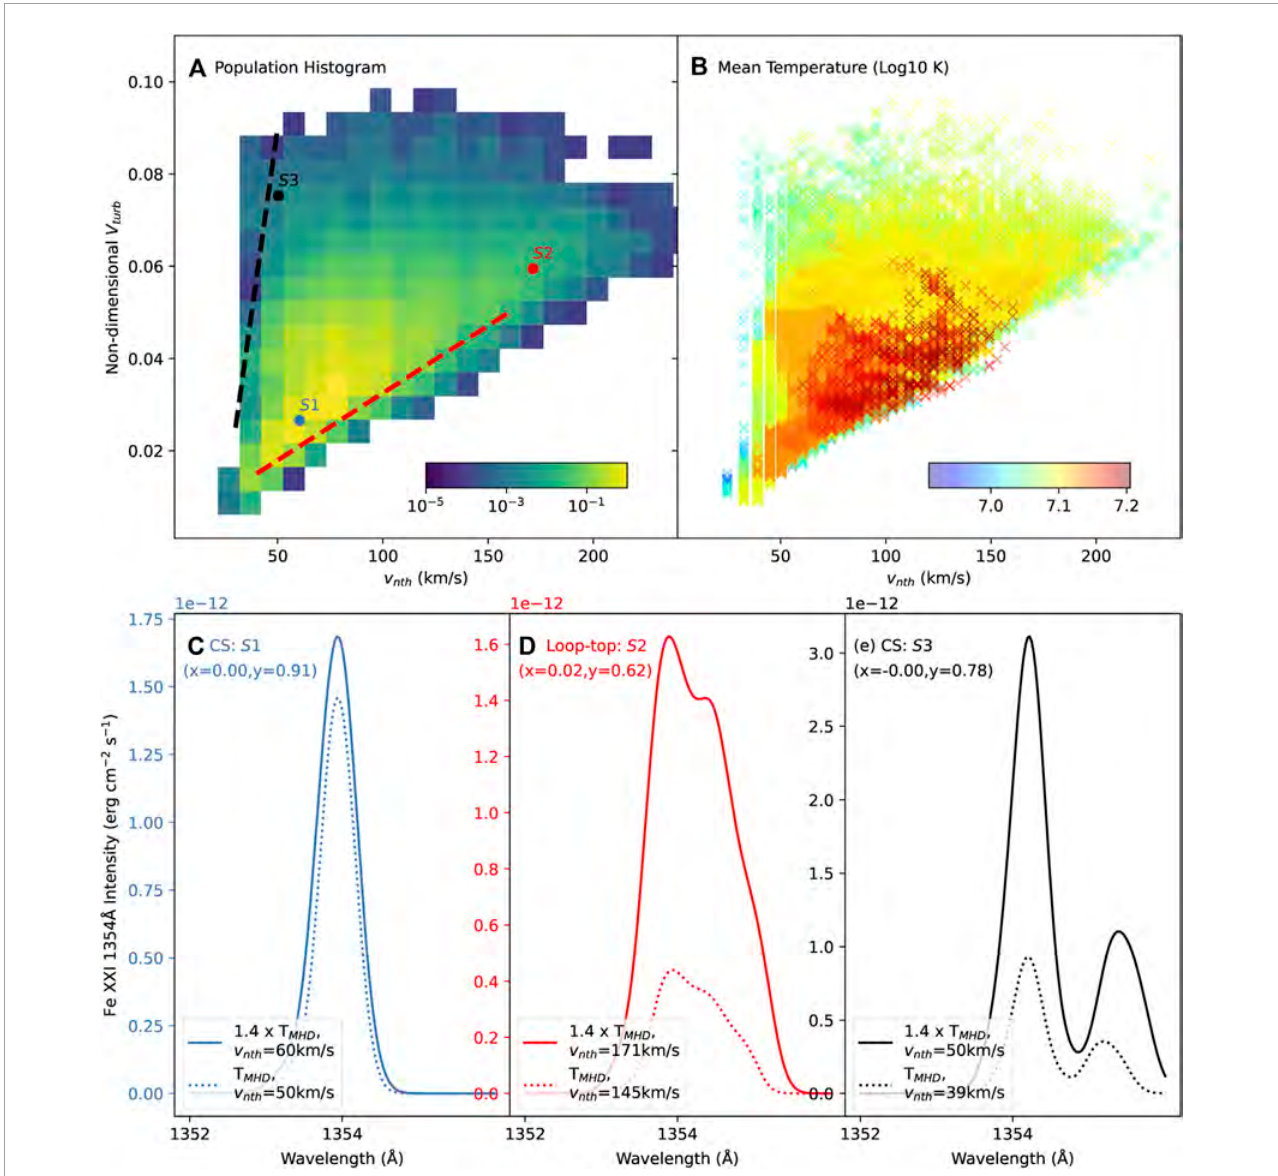
FIGURE 12 Distribution of the deduced non-thermal velocity v nth in the scaled temperature case. Panels (A) (B) show v nth - V turb map in a 1 . 4 × higher temperature situation compared with the original temperature ( T MHD ). The red and black dashed lines are the same as in Figure 11A . Panels (C–E) show synthetic Fe XXI 1354 Å line profiles at the marked sampling points in panel (A) : S 1 and S 3 are located in the reconnection current sheet (CS) region, and S 2 is above the flare loop-top region. Their projected position on the xoy plane are marked by ( x , y ) accordingly. The solid lines are for 1 . 4 × scaled temperature cases and the dotted lines are for T MHD